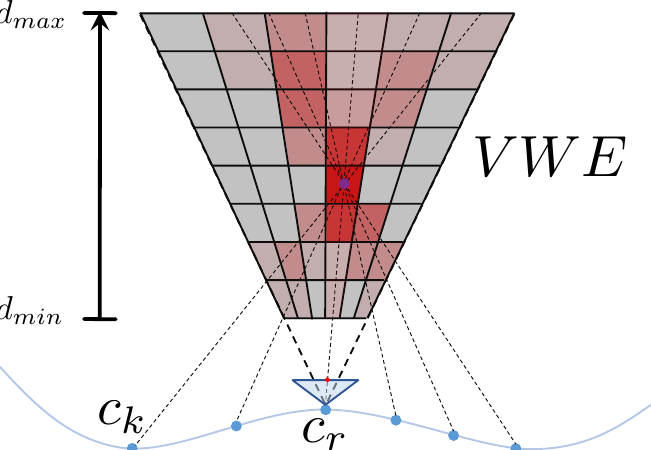
Figure 1. Volume of Warped Events: Events are transformed into rays that are warped in space based on a continuous time trajectory model. We evaluate the ray density in a volume in front of a reference view and maximize its contrast as a function of the continuous motion